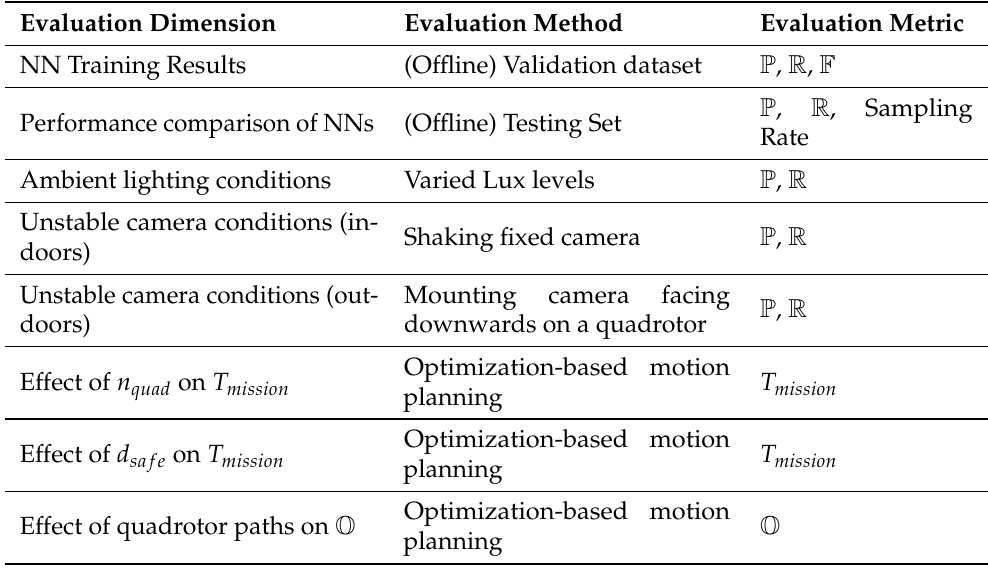
Table 1. Summary of the evaluations and relevant metrics performed in this